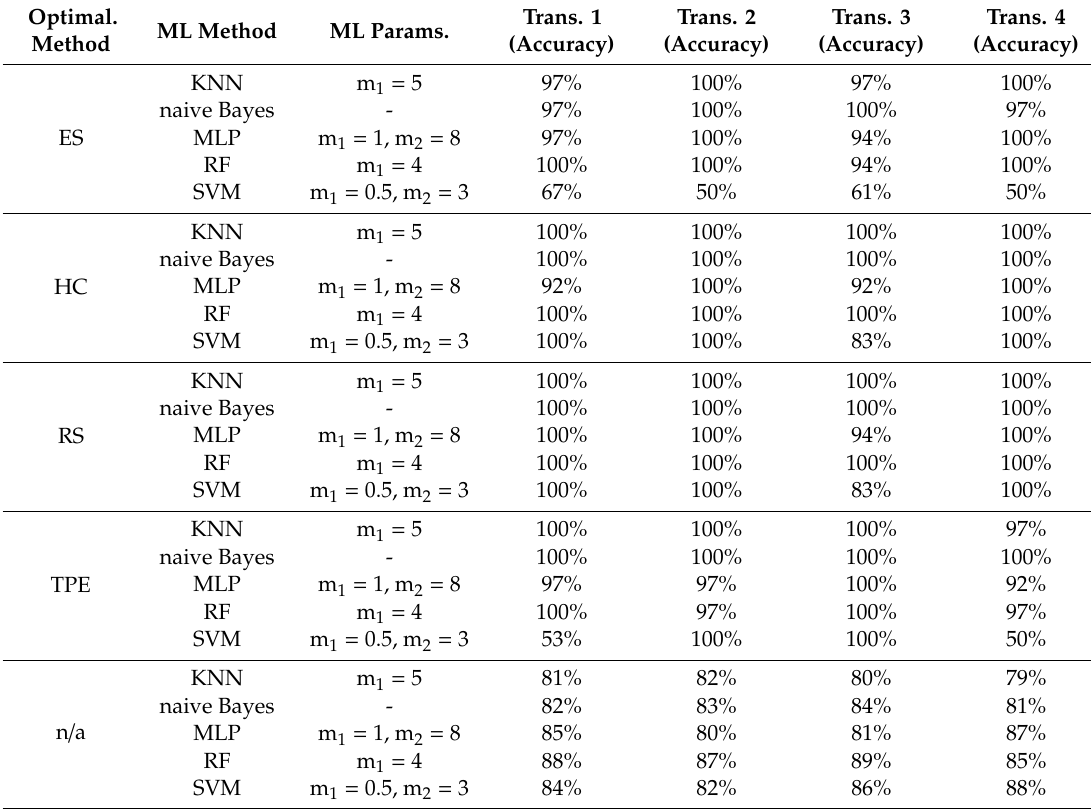
Comparison of various machine learning methods for each transformer and its acoustic